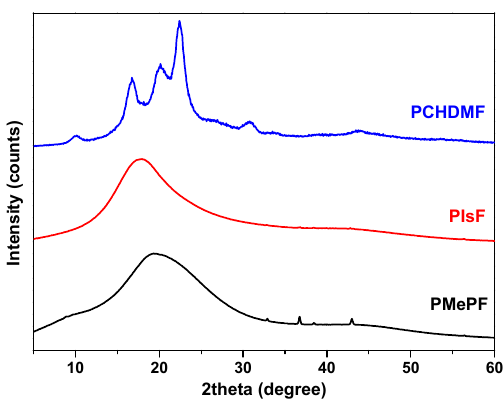
Figure 3. WAXD diffractograms of PMePF, PIsF and PCHDMeF.